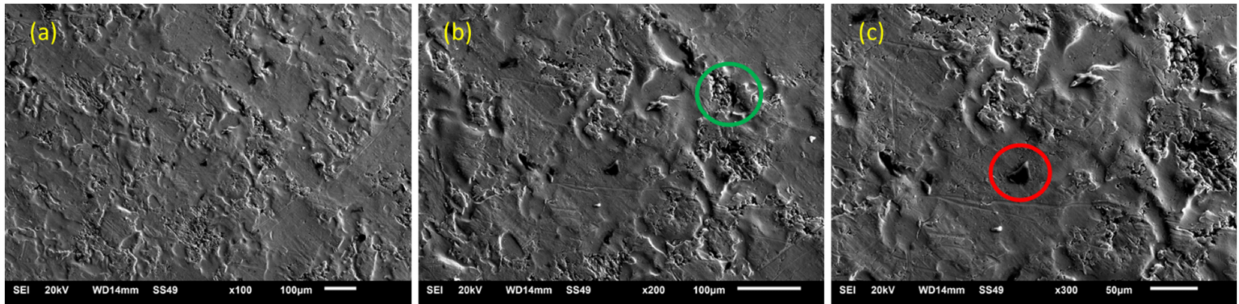
Figure 7. SEM micrographs of as-received sheet; ( a ) 100 × , ( b ) 200 × and ( c ) 300 ×